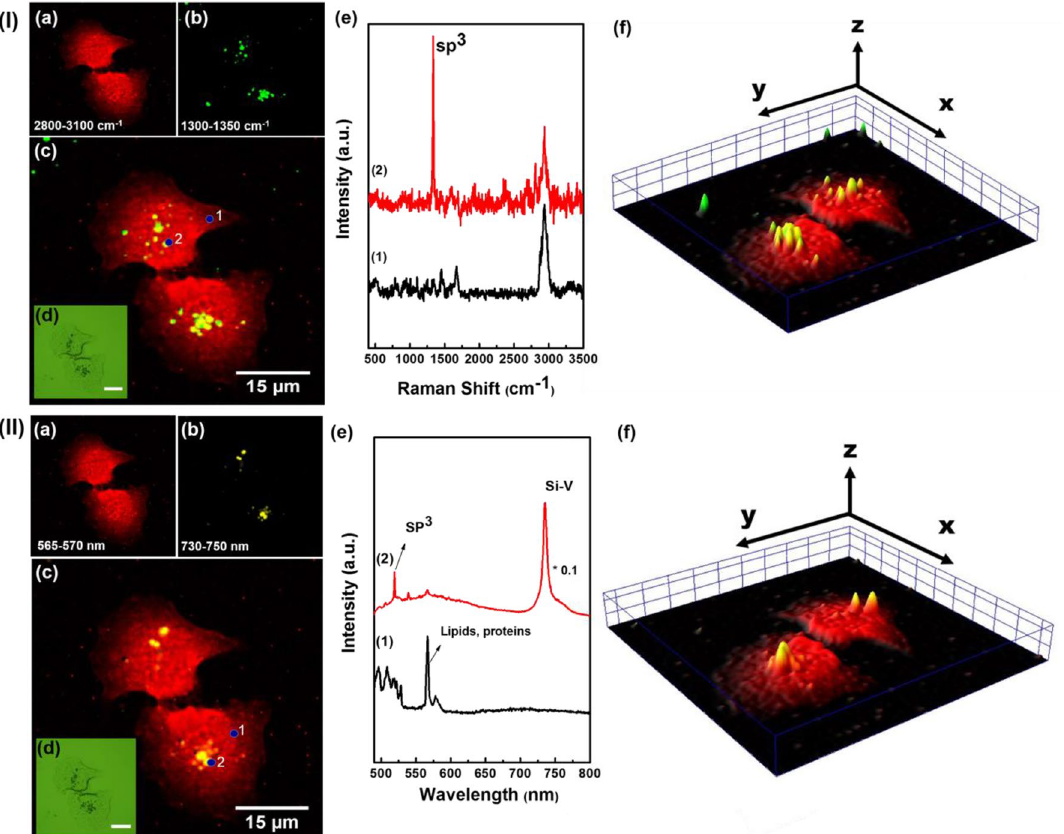
Figure 4. Visualization of ND@Au interaction with A549 cell via Raman mapping ( I ) and mapping of fluorescence ( II ). ( I ): (a) The cell is shown via mapping the distribution of intensity at 2800–3100 cm −1 ; (b) ND@Au NP are shown using ND Raman signal (mapping of the signal in range 1300–1350 cm −1 ); (c) merging of (a) and (b); (d) the optical image; (e) Raman spectra according to (c) measured in points marked 1 (cell) and 2 (the cell with ND@Au). (f) 3D Raman mapping reconstructed via the spectral signal intensity. ( II ) (a) The cell is shown via mapping the distribution of intensity at 565–575 nm; (b) ND@Au NP are shown via fluorescence of ND SiV center (730–750 nm); (c) merging of (a) and (b); (d) the optical image; (e) spectra measured from (c) point 1 (cell) and point 2 (the cell with ND@Au); (f) 3D mapping re-constructed via spectra intensity. The concentration of ND@Au was 20 µg/ml. excitation 488